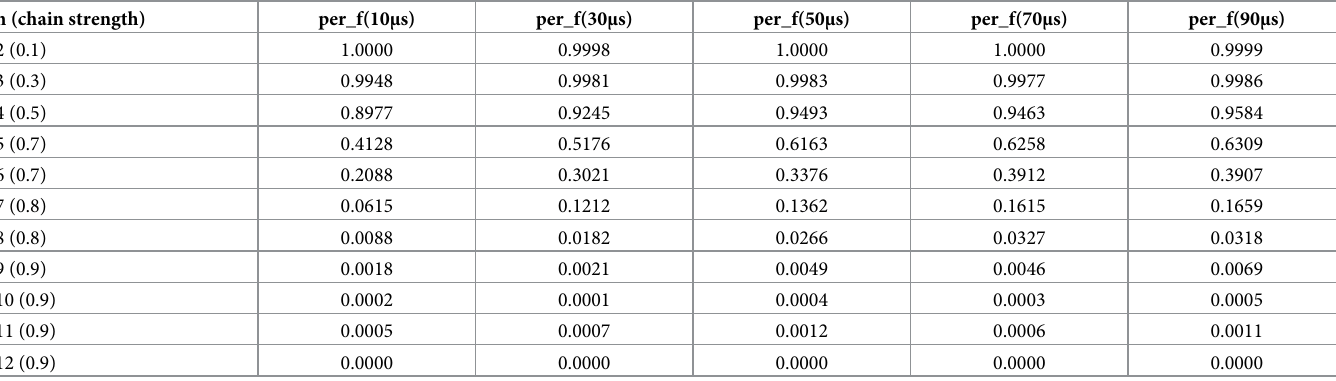
Table 5. Probability of obtaining feasible solutions with the tuned chain strength